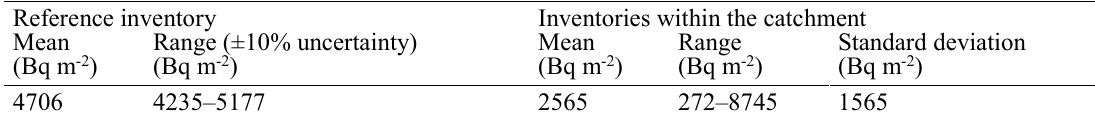
Table 1 137 Cs inventories for the Melito catchment.